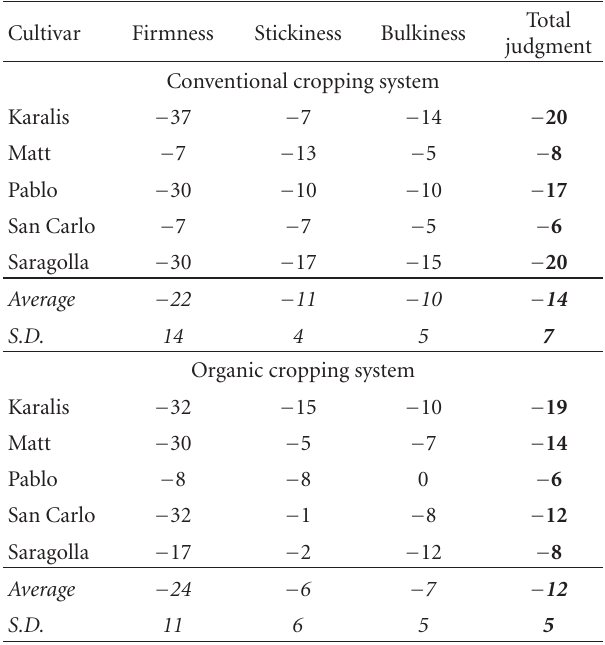
Table 6: Resistance to overcooking expressed as the di ff erence between SCT and